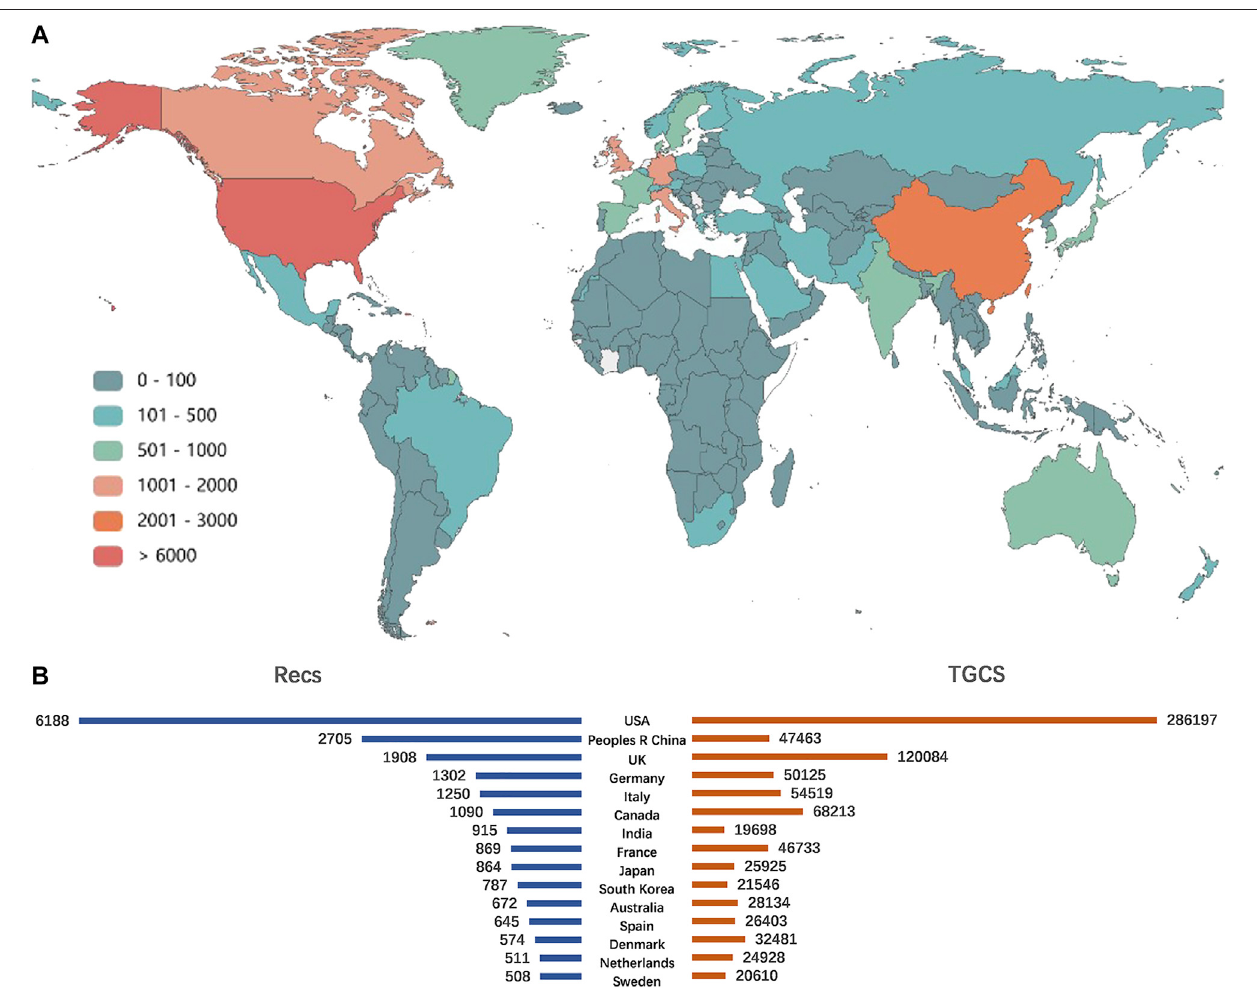
FIGURE 2 | Main countries/regions distribution on metformin publications. (A) Geographical distribution of metformin. (B) The top 15 most productive countries in the publication of metformin and their corresponding TGCS.